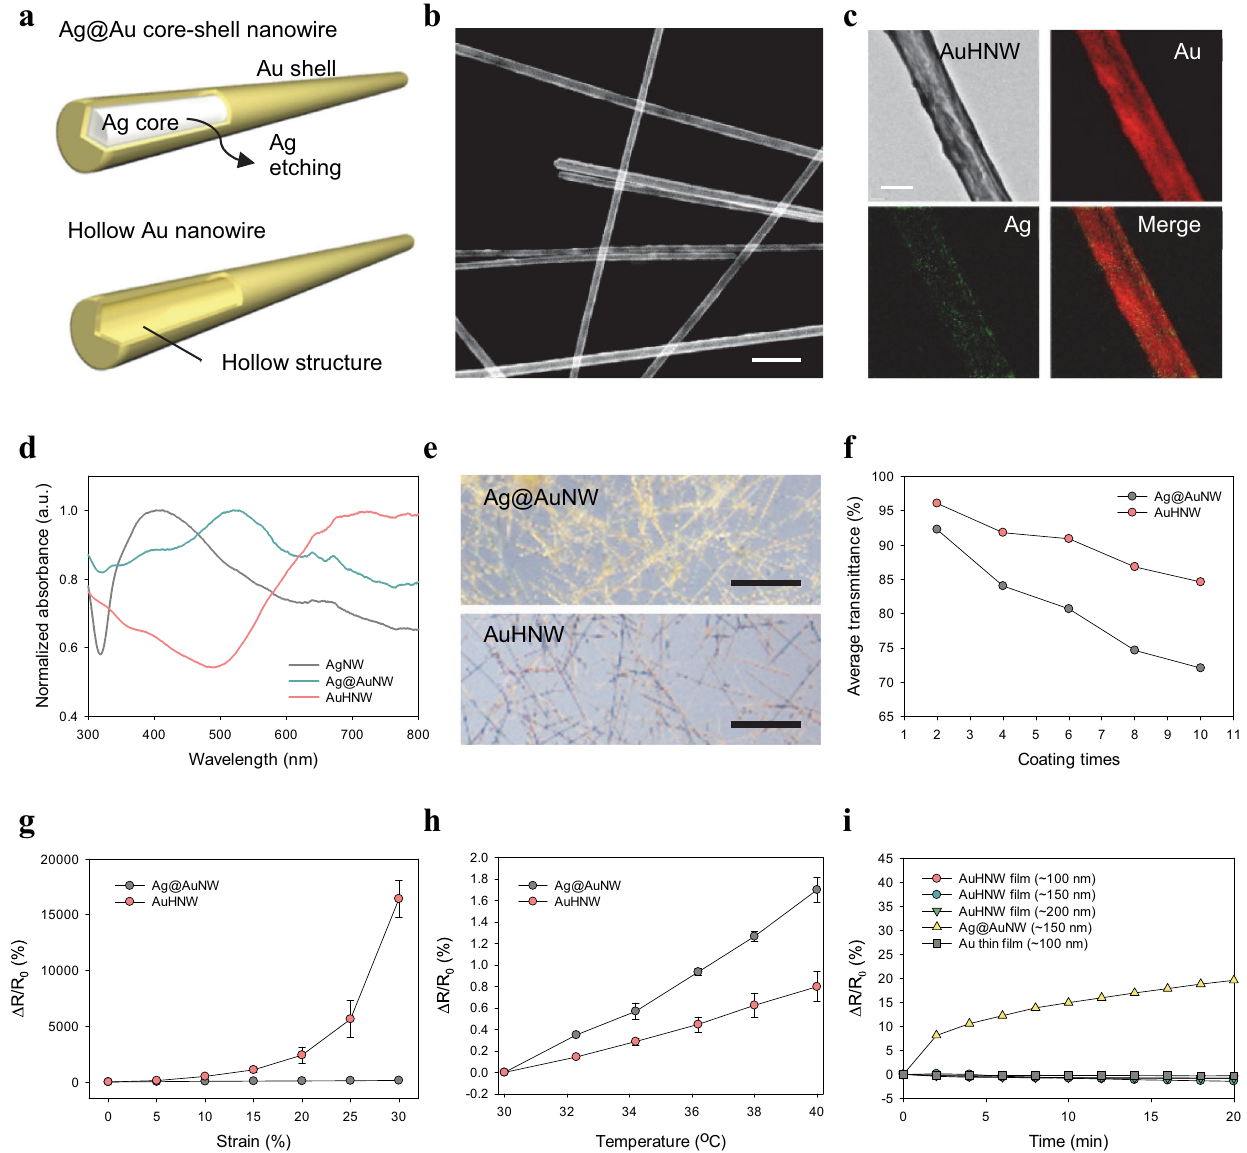
Fig. 2 | Characteristics of synthesized AuHNWs. a Schematic illustration of Ag@AuNW and AuHNW. b TEM images and c EELS images of AuHNWs (scale bar, 1 μ m and 100nm). d The normalized absorbance of AgNW, Ag@AuNW, and AuHNW. e OM images of Ag@AuNW and AuHNW fi lms (scale bar, 5 μ m). f The average transmittance change of each nanowire with increasing coating